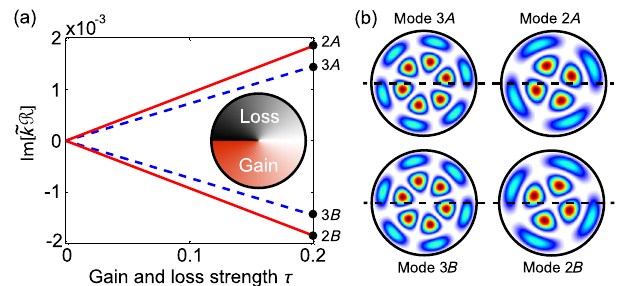
FIG. 1. Absence of PT transitions in a PT -symmetric disk with no additional discrete symmetry. The gain and loss gradient is given by g ð r; ϕ Þ ¼ ϕ = π ð r > R= 5; − π < ϕ < π Þ ; 0 ð r ≤ R= 5 Þ and shown schematically as the inset in (a). (a) Evolution of the imaginary part of two pairs of initially degenerate eigenfrequen- cies as a function of τ . Solid and dashed lines represent modes with a dominant angular momentum m ¼ 2 ; 3 , respectively. These numerical results cannot be distinguished from the approximation (4). (b) Intensity profiles of the four marked modes in (a) at τ ¼ 0 . 2 . Dashed lines show the designated P axes. The refractive index n ¼ 3 . 3 is used in all